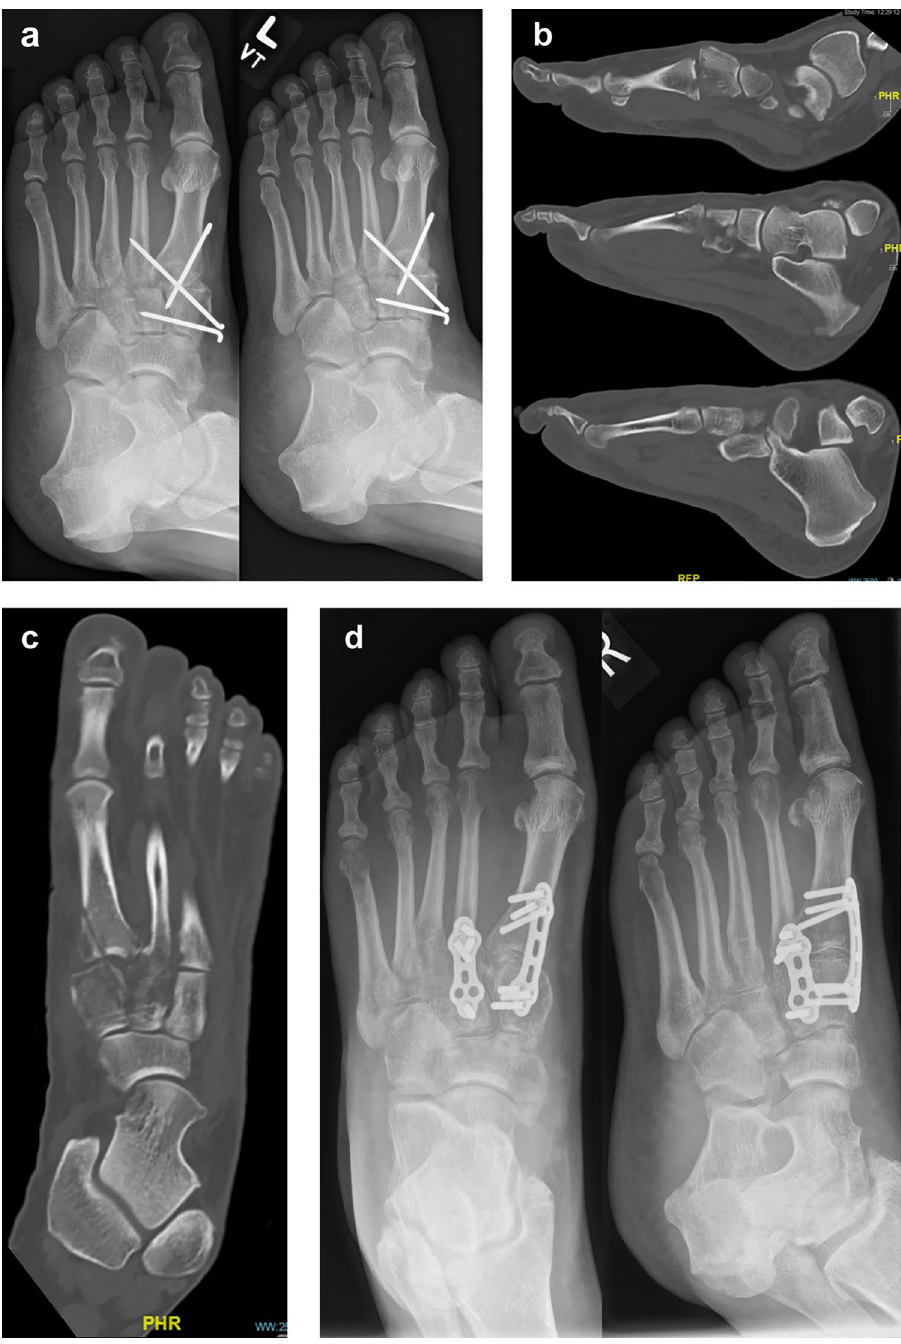
Figure 4. A 39-years-old female patient had a distortion trauma of her right midfoot resulting in a Lisfranc injury involving first and second tarsometatarsal joints. ( a ) She underwent a closed reduction of the Lisfranc joint and transfixation using Kirschner-wires (in an outside hospital). ( b ) Eight weeks later Kirschner wires were removed, and CT scan was performed demonstrating substantial dislocation of the first (top) and second (middle) tarsometatarsal joints. The alignment of the third tarsometatarsal joint was OK (bottom). ( c ) Severe dislocation of the first and second tarsometatarsal joints has been also confirmed using axial CT scan. ( d ) Revision surgery was performed including open anatomic reduction of both dislocated joints and transfixation using two locking